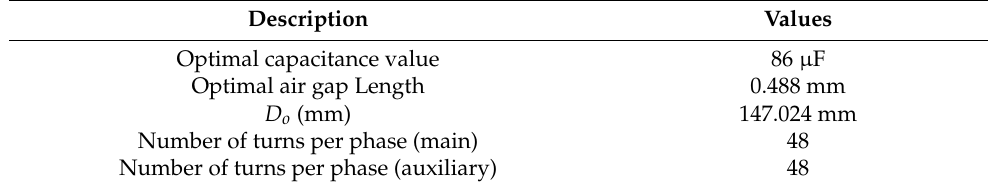
Table 5. Optimized design